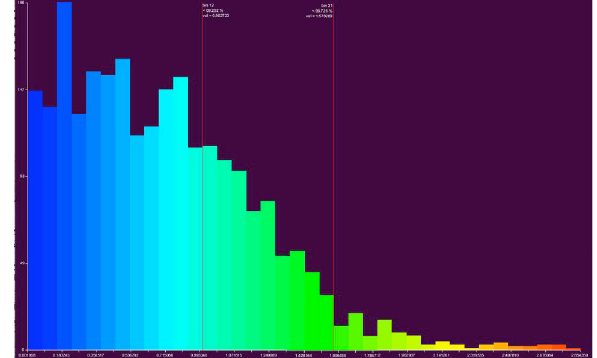
Figure 1: The distribution of roughness values the scale of 5m. The 1 σ and 2 σ cut-off points are indicated by red vertical